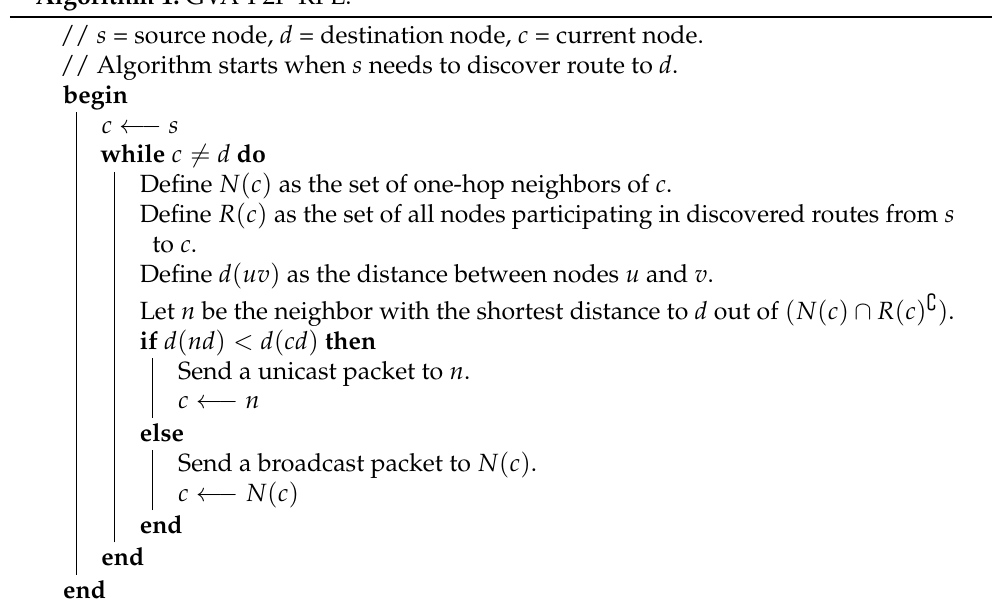
Figure 5. GVA-P2P-RPL. ( a ) The network node connectivity, where the gray nodes are void nodes that have no neighbor node closer to the destination than themselves. From ( b – g ), P2P-DIO messages are greedily forwarded when possible and locally broadcast when void nodes are encountered. The solid arrows are greedily forwarded P2P-DIO messages, and solid dashed arrows are locally broadcast P2P-DIO messages. ( e ) The final P2P route chosen by the destination as the solid arrows. Algorithm 1: